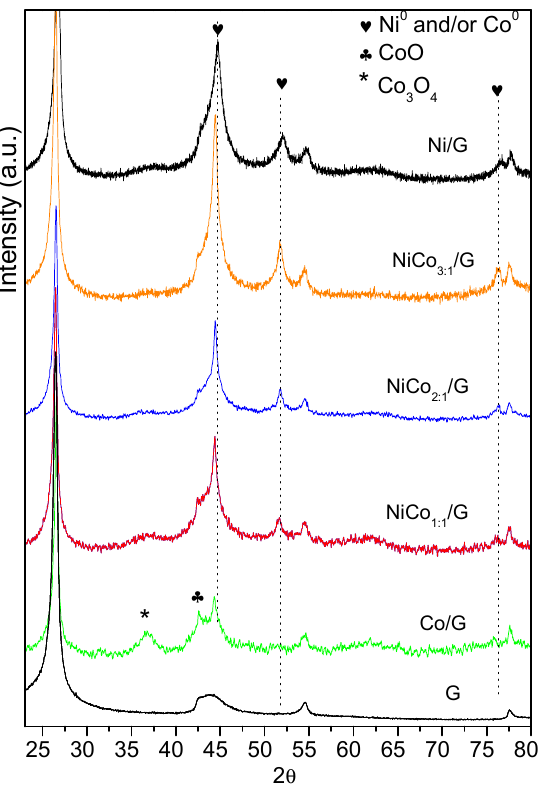
ff ractogram obtained for the support and the prepared Figure 2. Diffractogram obtained for the support and the prepared catalysts. Figure 2. Di